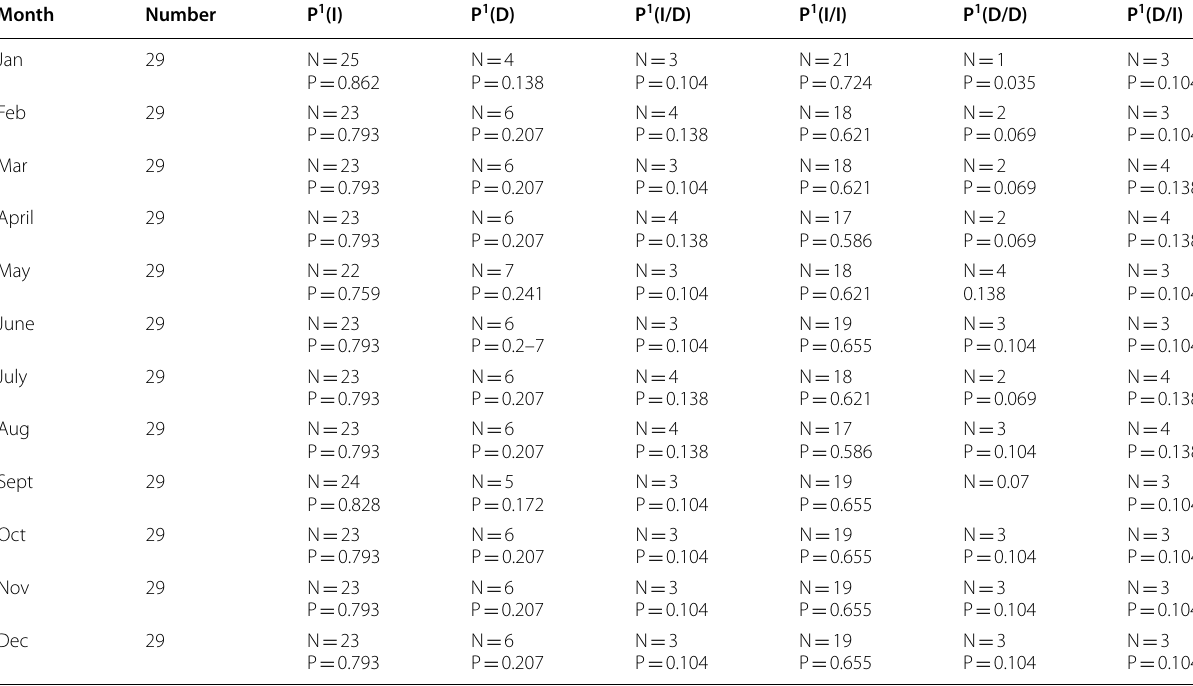
Table 6 Probability of all the monthly share prices. Source: Authors computation with data generated from NSE Month Number